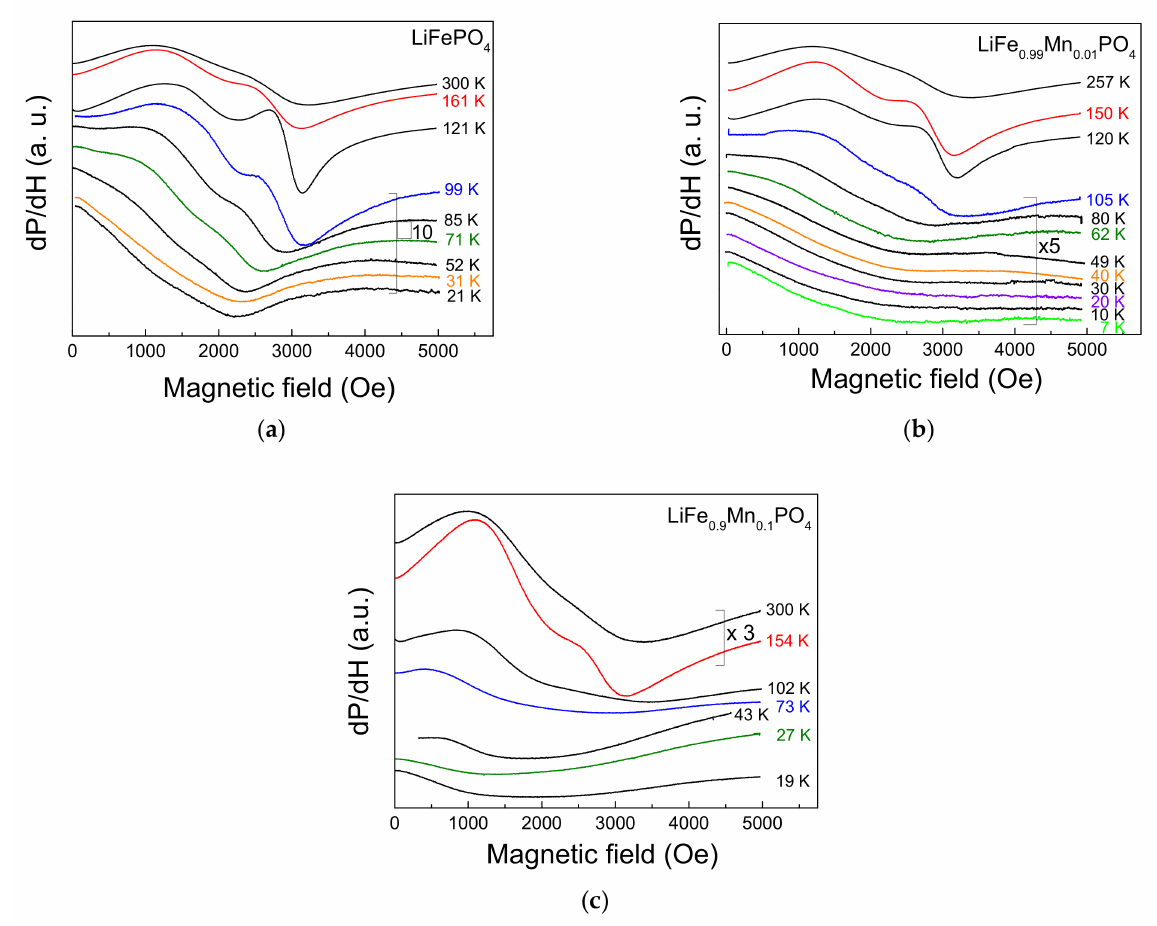
Figure 1. Electron spin resonance spectra of LiFe 1 − x Mn x PO 4 : ( a ) x = 0, ( b ) x = 0.01, and ( c ) x = 0.1 at different temperatures. The intensity of some experimental spectra was multiplied for clarity.